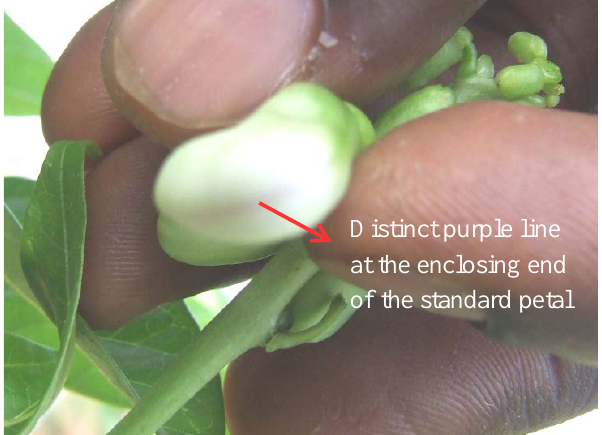
Fig. 3. A qualitative indicator of flower bud maturation